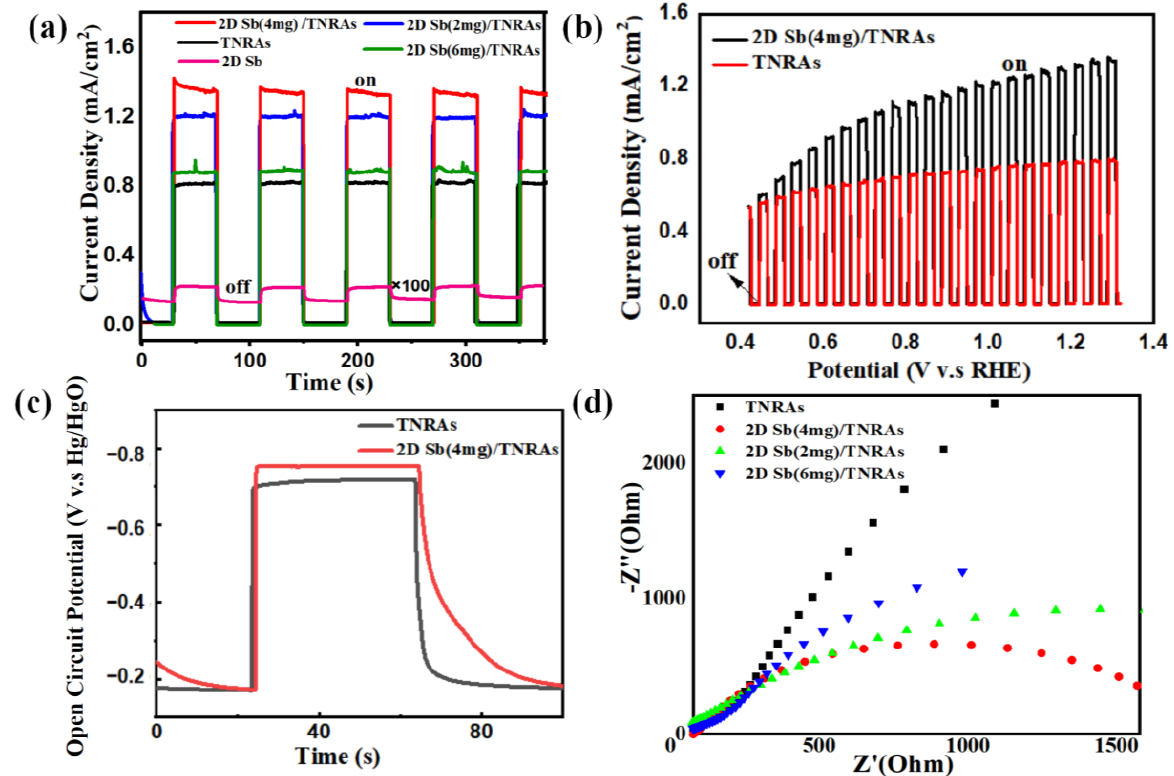
Figure 5. The PEC performance of the synthesized 2D Sb/TNRAs photoanodes with different 2D Sb loading measured in 1 M KOH under AM 1.5 G irradiation. ( a ) Transient photocurrent responses collected at 1.23 V vs. RHE. (The photocurrent density of 2D Sb is amplified 100 times for comparison). ( b ) LSV curves. ( c ) Open-circuit potential curves. ( d ) EIS spectra. TNRAs: TiO 2 NRAs; 2D Sb (4 mg)/TNRAs: 2D Sb (4 mg)/TiO 2 nanorod arrays.